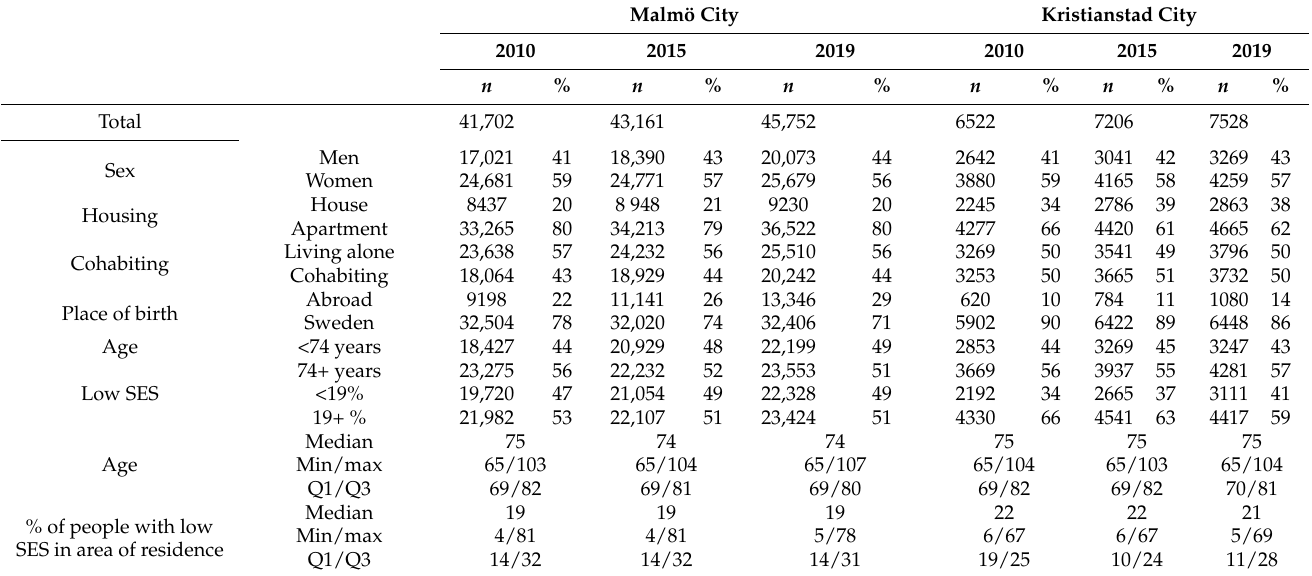
Table 3. Sociodemographic characteristics of the study population in Malmö city and Kristianstad city. Malmö City Kristianstad City